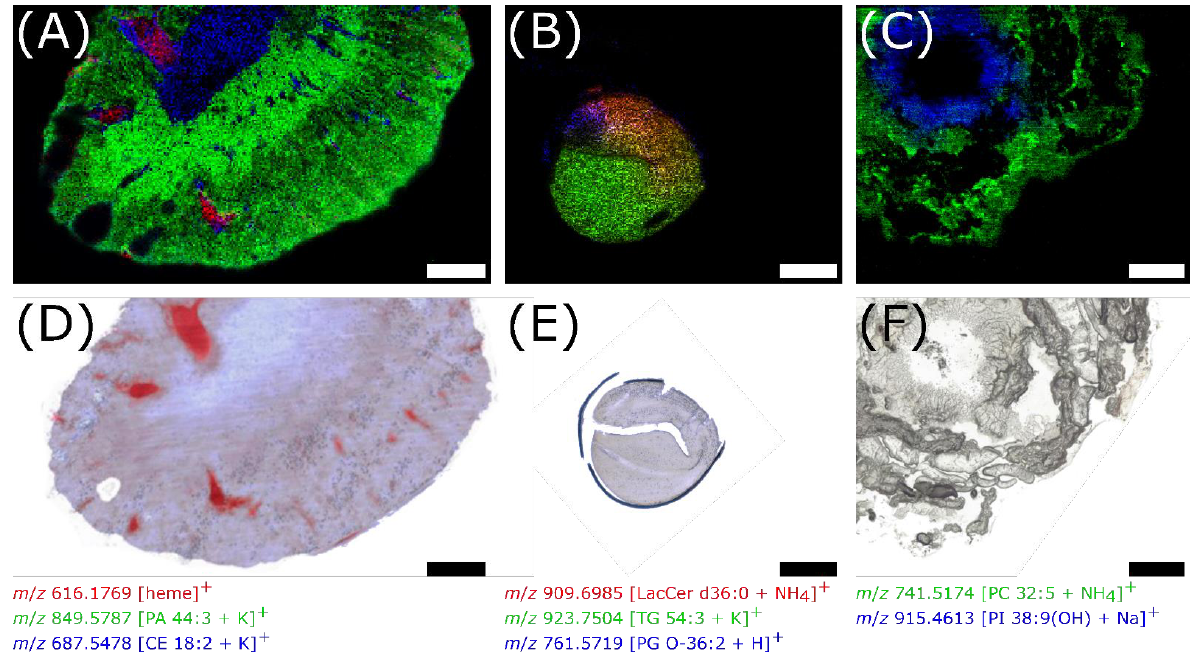
Figure 5. MS images of tissue sections from various organisms using DIUTHAME as the ionization assisting membrane ( A – C ) and corresponding microscopic images of the same ( E ) or an adjacent section ( D , F ). ( A ), 50 µm thick mouse kidney section, pixel size 30 µm, 276 × 161 pixels, m / z 400–1600. ( B ), 80 µm thick germinating rapeseed section, pixel size 20 µm, 297 × 245 pixels, m / z 500–1500. ( C ), 150 µm thick Spodoptera littoralis caterpillar section, pixel size 20 µm, 300 × 250 pixels, m / z 250–1000. Scale bars: 1 mm.